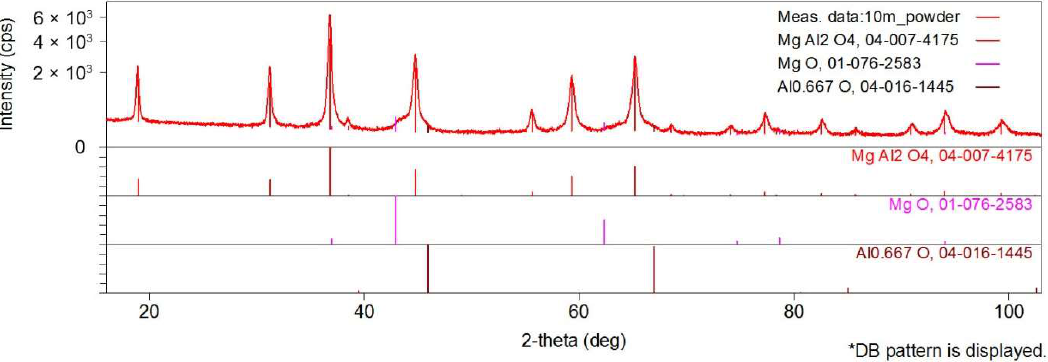
Figure A6. AZ63_10m in powder form sample—XRD qualitative phase analysis with displayed PDF cards peak bars.